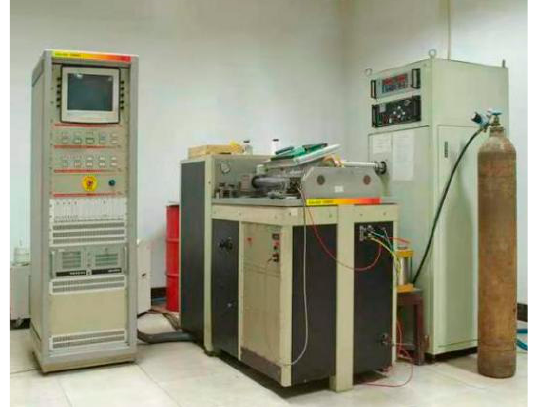
Figure 1. Gleeble-1500D thermal simulation testing machine. Table 1. Chemical compositions of Cr5 steel in wt%.